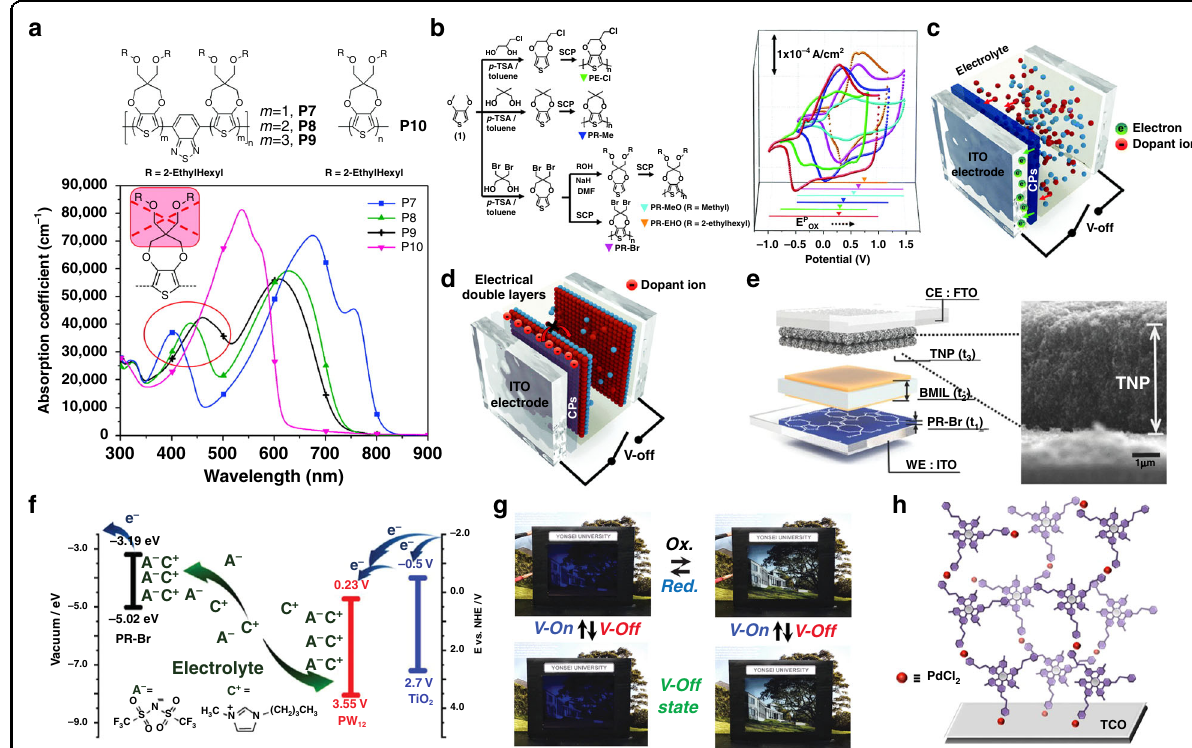
Fig. 3 Latest developments in various organic electrochromic materials and devices. a Spectral regulation of conjugated polymers based on the “ donor – acceptor ” approach 48 . b Synthetic routes and structure for EC polymers, including PE-Cl, PR-Me, PR-MeO, PR-EHO, and PR-Br, based on the “ donor – acceptor ” approach, and the corresponding cyclic voltammograms 50 . c Schematic diagram of the interfacial electron transfer between ITO and an EC polymer 50 . d Schematic diagram of the electrical double layers formed by dopant ions 50 . e Schematic diagram of an EC device containing a TiO 2 layer (BMIL, 1-butyl-3-methylimidazolium bis(tri fl uoromethylsulfonyl)imide; WE, working electrode; CE, counter electrode; RE, reference electrode) 55 . f Mechanism of the charge-balancing effect of the ion storage layer containing TiO 2 and PW 1156 . g Photographic images of bistable electrochromic windows 50 . h Schematic diagram of the assembly process of organic – metallic hybrid EC materials. TCO, transparent